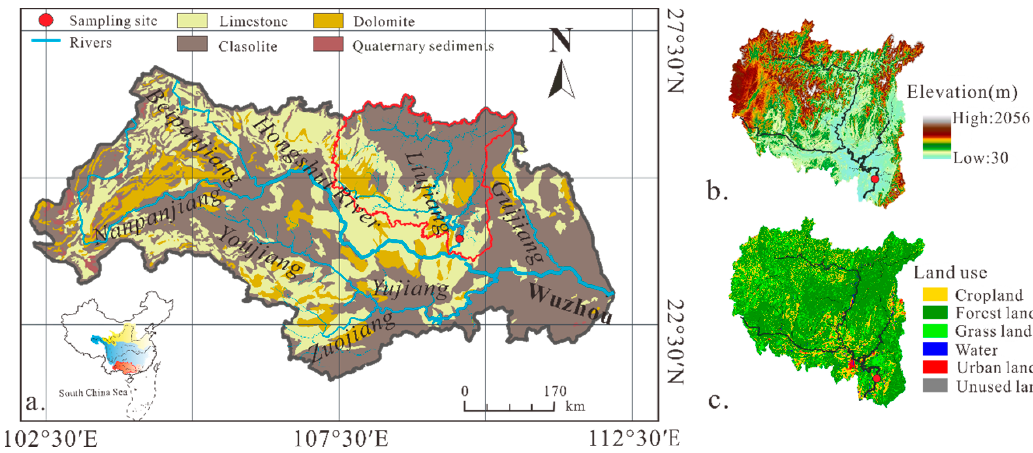
Figure 1. Map showing sampling location, geological background, digital elevation model (DEM), and land use types of the Liujiang River catchment.